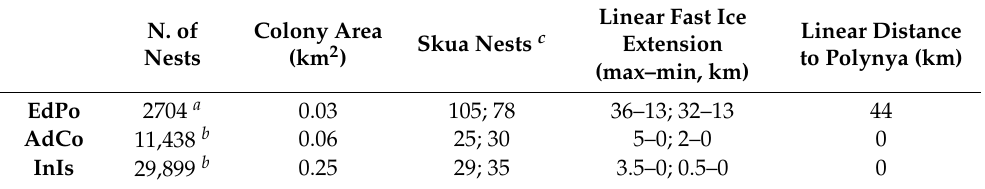
a Data from ground census of 29 November 2017, this study. b Data from aerial census of 2018 and 2019 [43]. c Data from ground census (December 2017 and 2018, this